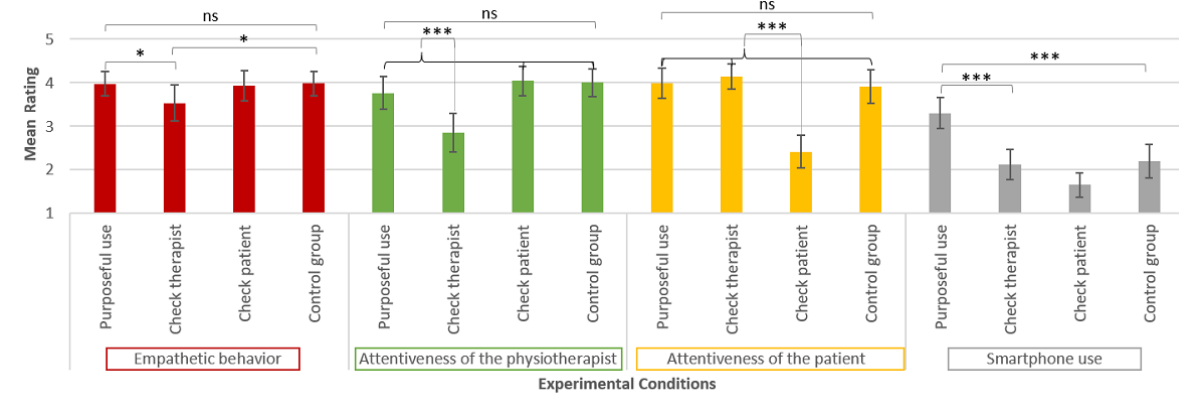
Figure 4. Means and CIs for the outcome variables empathetic behavior, attentiveness of the physiotherapist, attentiveness of the patient, and smartphone use in the four experimental conditions. ns: nonsignificant. * P <.05, *** P